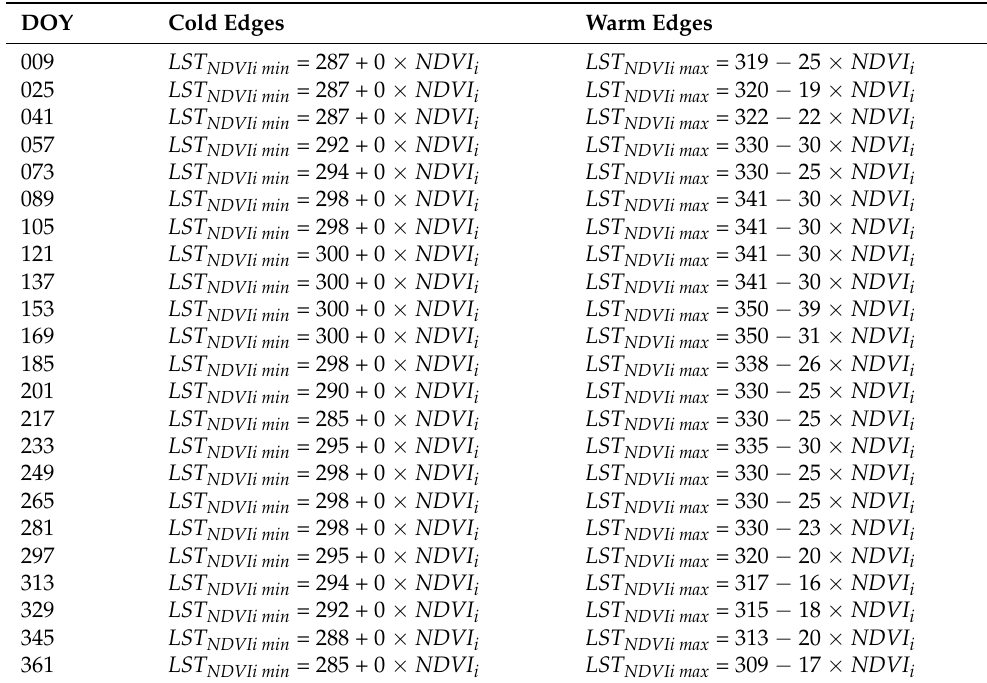
Table 1. Equations for the warm edges and cold edges for single years and multiple years from D-009 to D-169 during 2011–2014 and single-year from D-009 to D-361 during 2010. Warm edges are the thermal boundary defined as LSTmax Gains and Offset. Zero gain in cold edges are defined as LSTmin from D-009 to D-169. Day of the year (D) is presented here as (DOY). DOY Cold